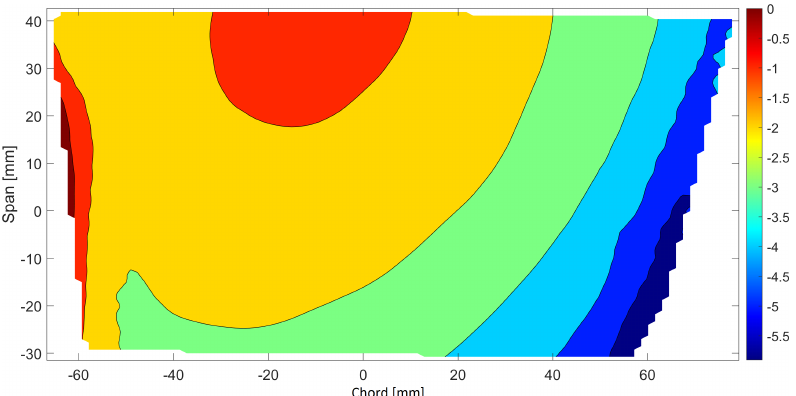
Figure 18. Difference between the measured and simulated numerical deflections for the static load case in